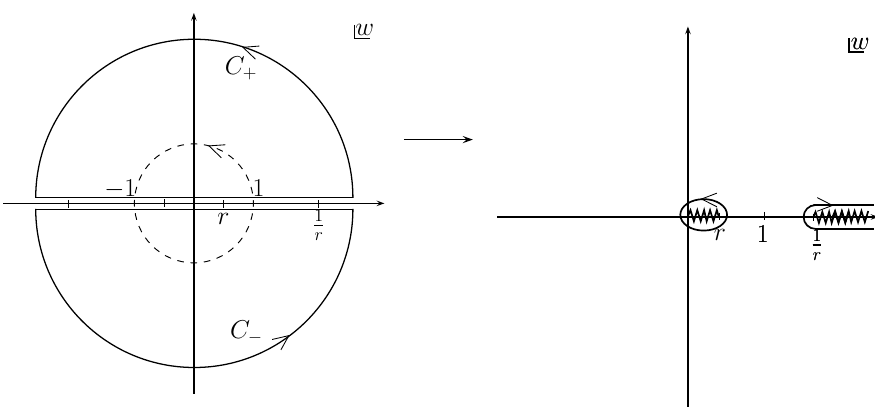
w = 1 contour of (3.24) used to de(cid:12)ne b 0 ( b (cid:1) ; s ) and b 1 ( b (cid:1) ; s ) j j